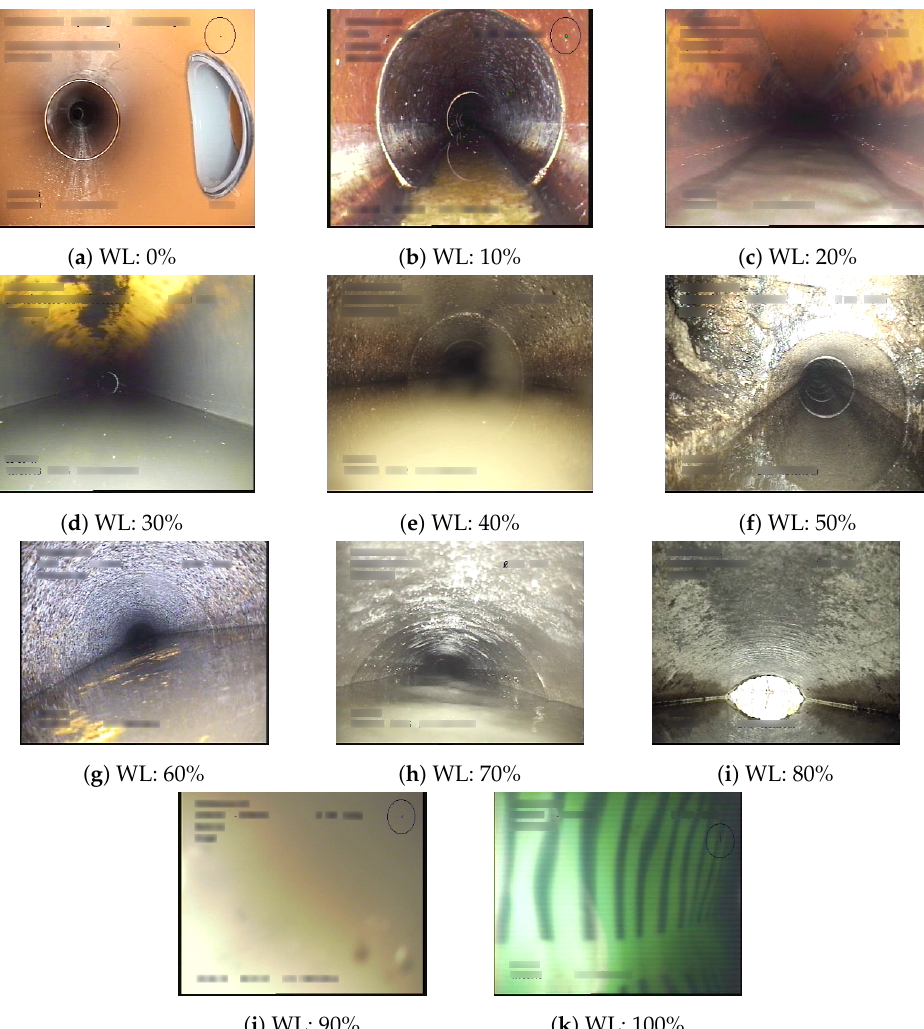
Figure 3. Images from the dataset that show the inter-class variation. WL is the annotated water